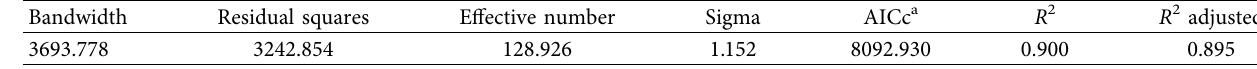
Table 6: Regression results of the GWR